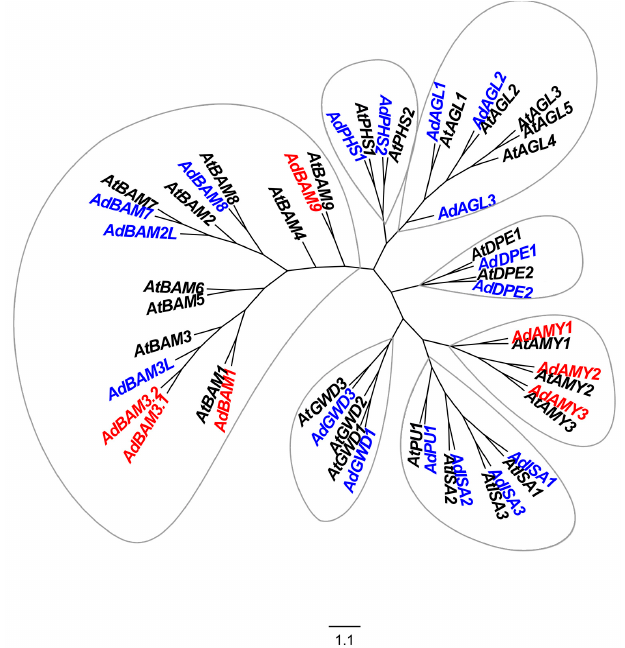
Figure 1. Phylogenetic analyses of starch-related genes from kiwifruit and Arabidopsis . Kiwifruit genes are highlighted in red (previously reported) and blue (newly isolated in the present research). The genes in black were the starch-related genes from Arabidopsis . The amino acid sequences of Arabidopsis genes were obtained from The Arabidopsis Information Resource or National Center for Biotechnology Information. The phylogenetic tree was constructed with Figtree (version 3.1, University of Edinburgh, Edinburgh, UK).